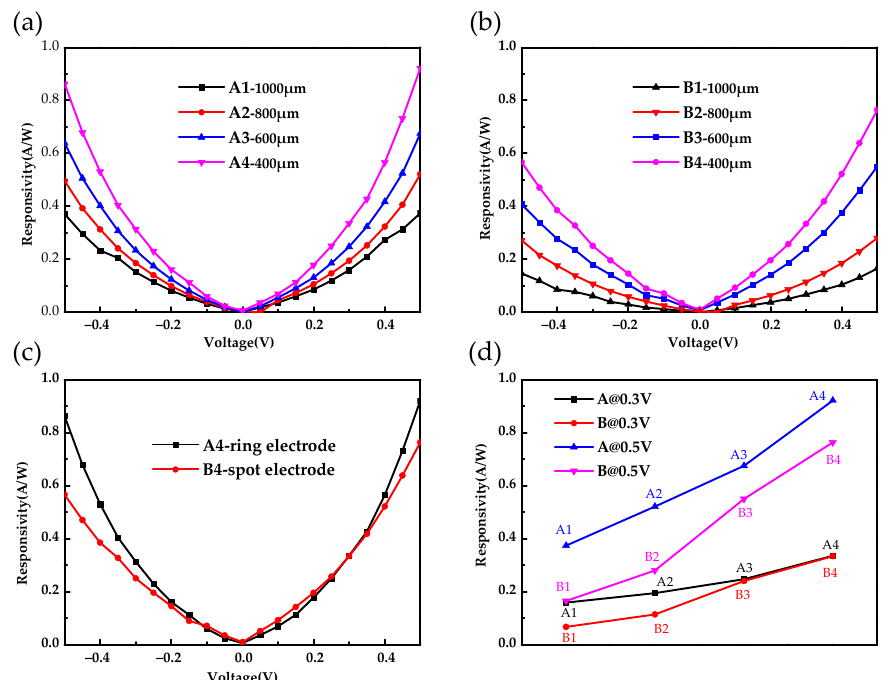
Figure 5. The blackbody responsivity of ( a ) A detectors and ( b ) B detectors. ( c ) Comparison of the blackbody responsivity of the A4 and B4 detectors. ( d ) Blackbody responsivity of the different detectors at 0.3 V and 0.5 V.